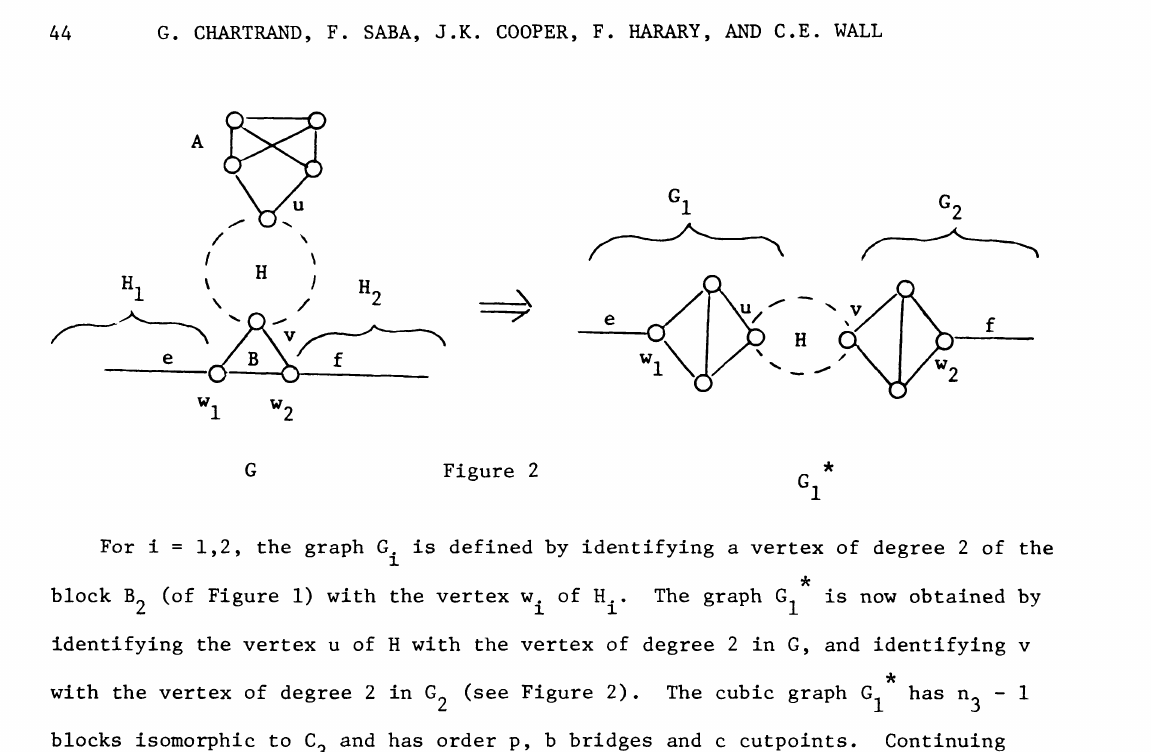
GI* Figure 2 , is now obtained by 1 The cubic graph G